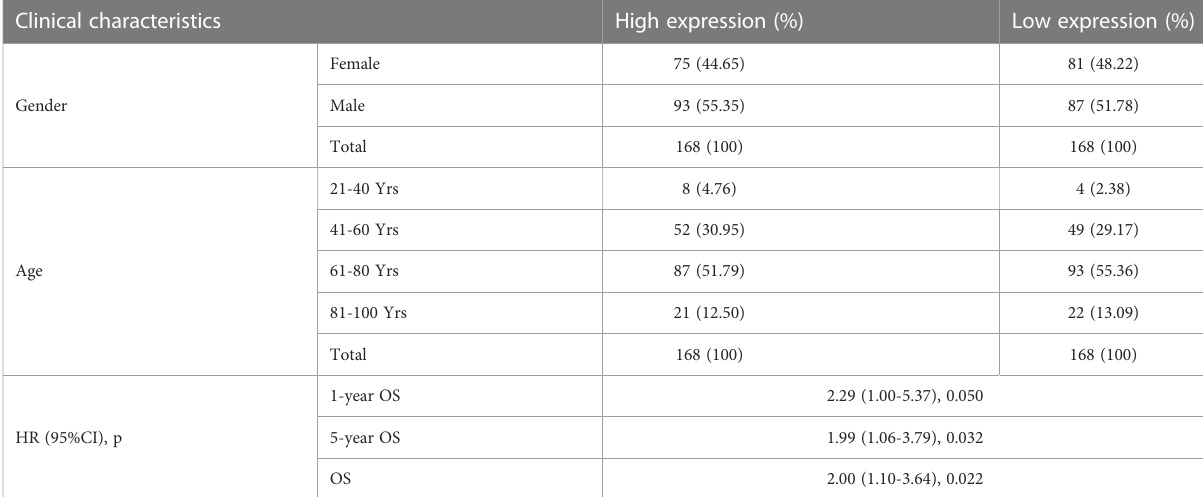
TABLE 2 Associations with overall survival and expression of ITG b 3 in patient data from TCGA using Cox regression. Clinical characteristics